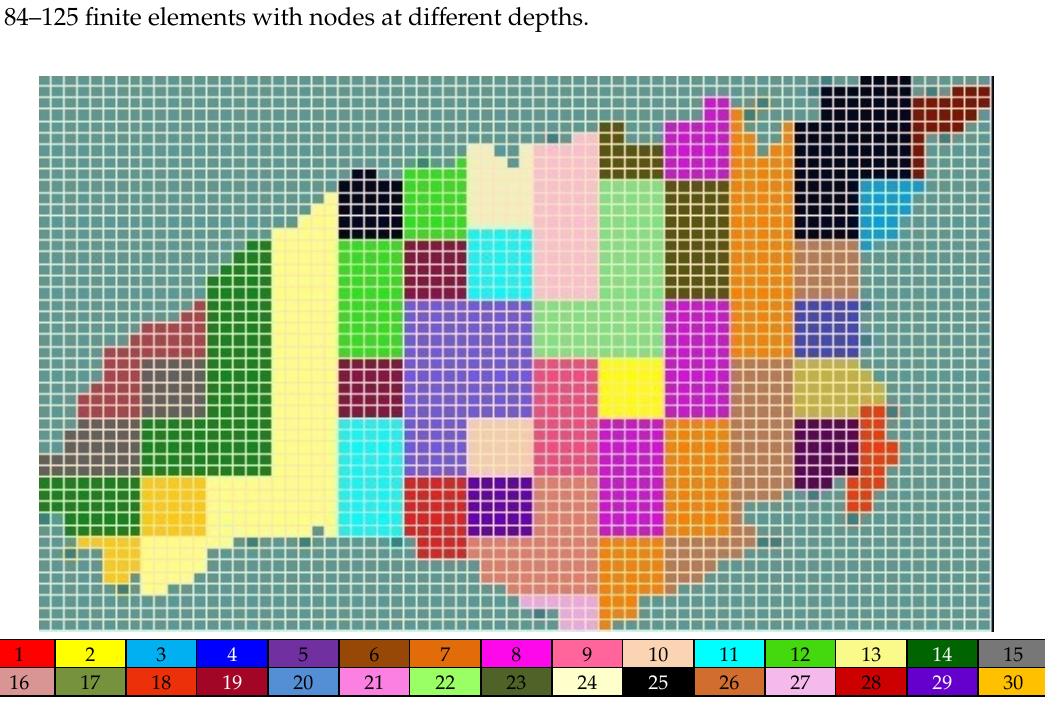
Table 2. Division of the stress periods in the groundwater flow model.